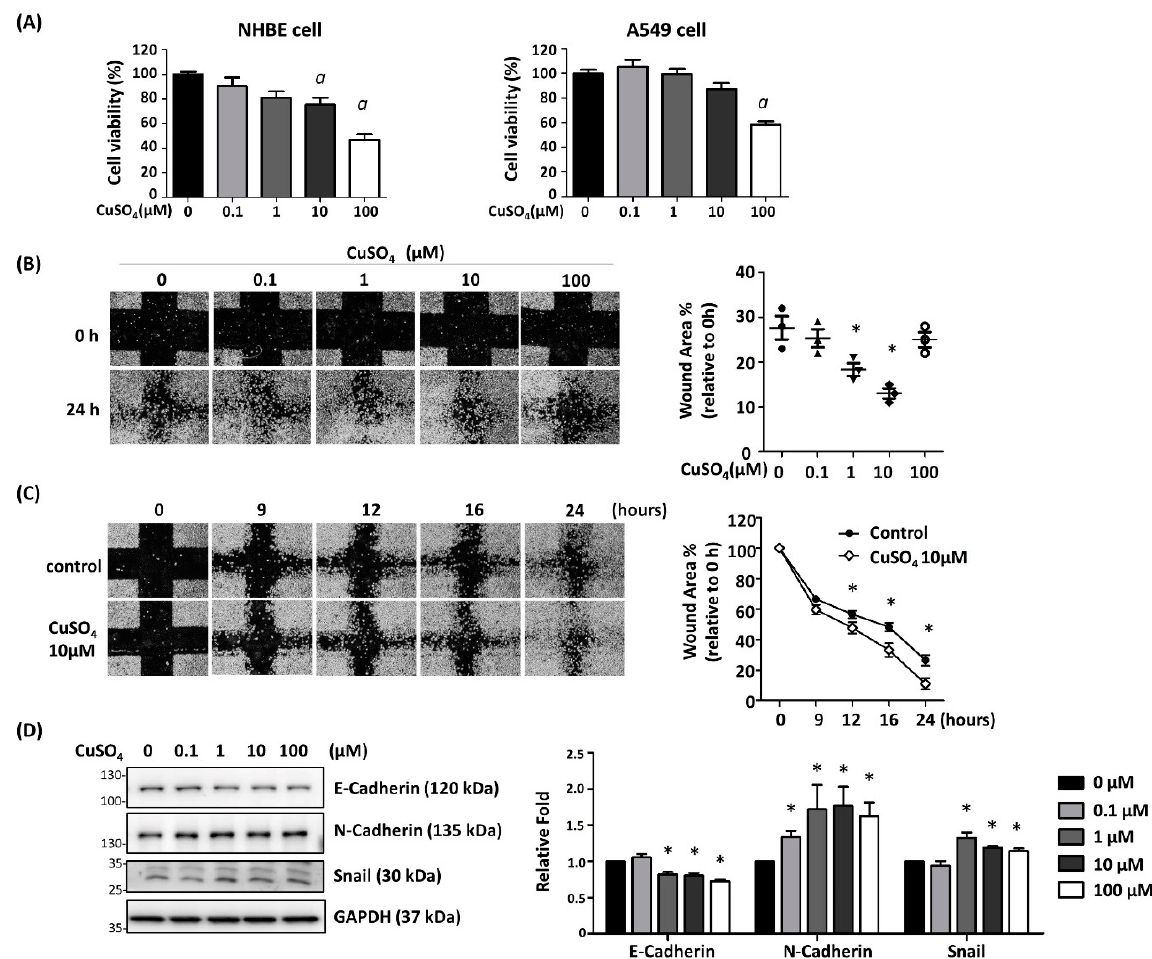
Figure 1. Dose and time effects of CuSO 4 on cell viability and EMT. ( A ) HBE and A549 cells were treated with various doses of CuSO 4 from 0.1~100 µ M for 24 h, and the cell viability was determined by CCK-8 assay. a : p < 0.05 compared with the control group. ( B ) The dose effect of CuSO 4 on A549 migration ability. A549 cells were treated with various doses of CuSO 4 for 24 h, and wounds were made for wound healing assay. 12 h after treatment, the wound coverage was determined. ( C ) The wound coverage of CuSO 4 -treated cells at different time points. A549 were treated with 10 µ M CuSO 4 and the wound coverage was determined. ( C ) At different time points after the wound was made, the GAP% was determined. The wound area was measured and represented as GAP%. Mean + SEM. ( D ) A549 cells were treated with various doses of CuSO 4 for 24 h. The protein expressions of EMT-related proteins were examined by Western blot. The quantitative results were shown in right panel. * p < 0.05. All experiments were performed three times and the representative image was shown.